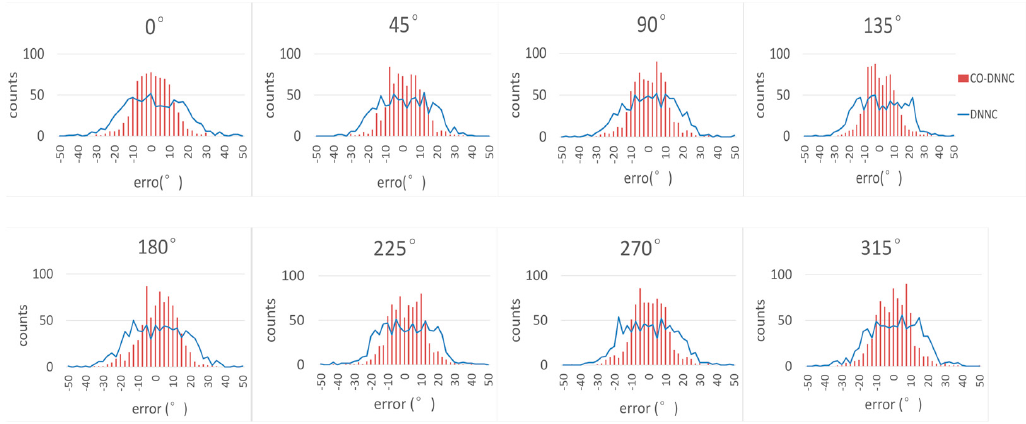
Figure 4. Error histogram of CO-DNNC and DNNC.